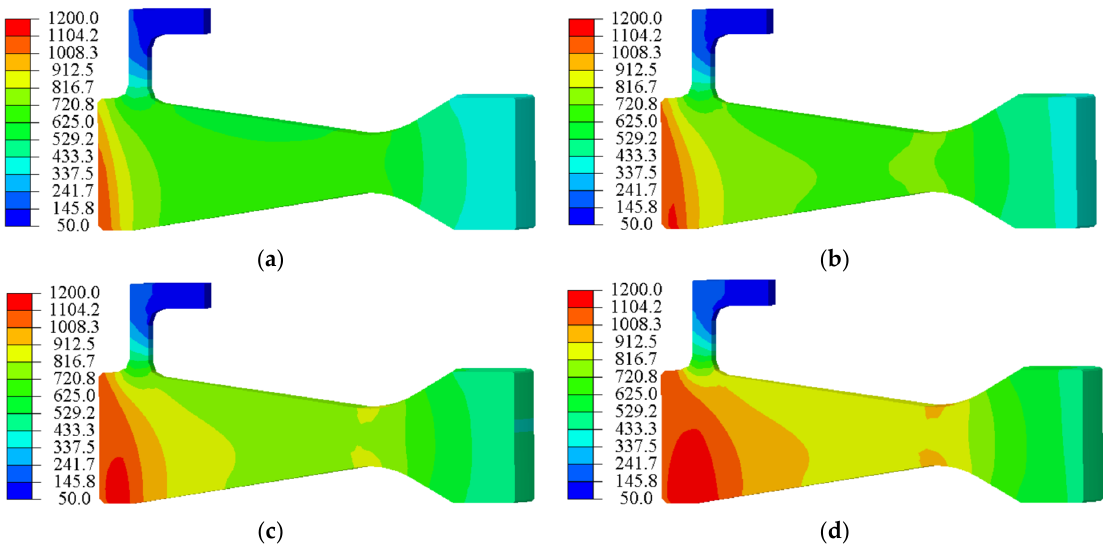
Figure 3. Hoop stress distribution at maximum rotation speed: ( a ) 42,500 rpm, ( b ) 45,000 rpm, ( c ) 47,500 rpm and ( d ) 50,000 rpm.